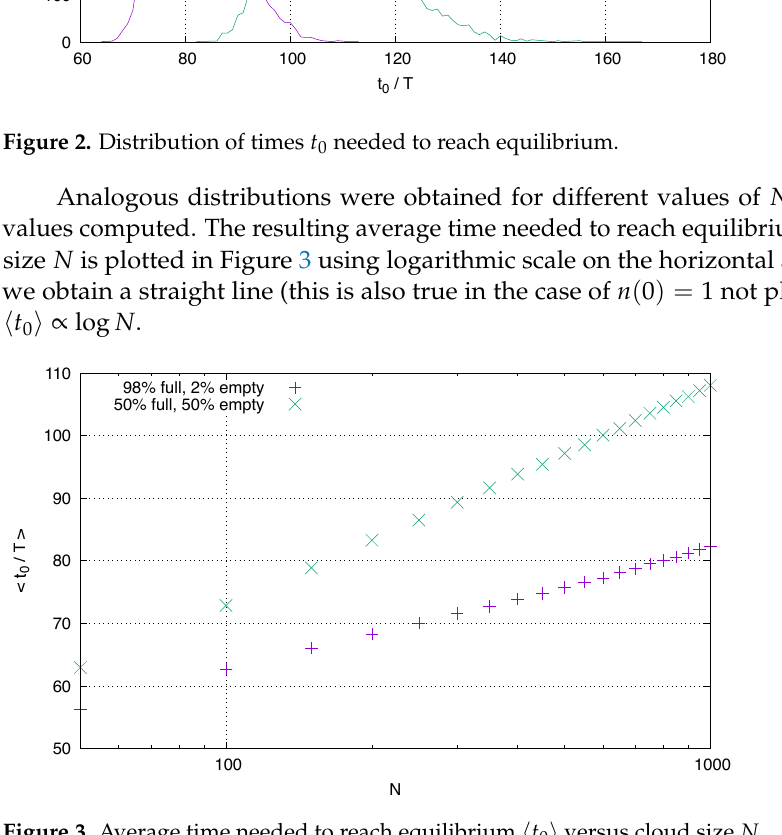
Figure 3. Average time needed to reach equilibrium (cid:104) t 0 (cid:105) versus cloud size N . A very important component not accounted for in our numerical experiments is the time needed by a container to find a suitable node to migrate onto. In the simulation all the nodes were arranged in a ring and linear search was used starting at the node after the current node. Search is done in parallel by all nodes. Therefore the search time needed to be added to t 0 at each time step is proportional to N (the worst case is 50% empty, 50% full because the number of containers needed to be migrated is largest). Thus, the time-complexity of the distributed algorithm for scheduling containers to cloud nodes presented in this paper should be (at least) linear-logarithmic O ( N log N )